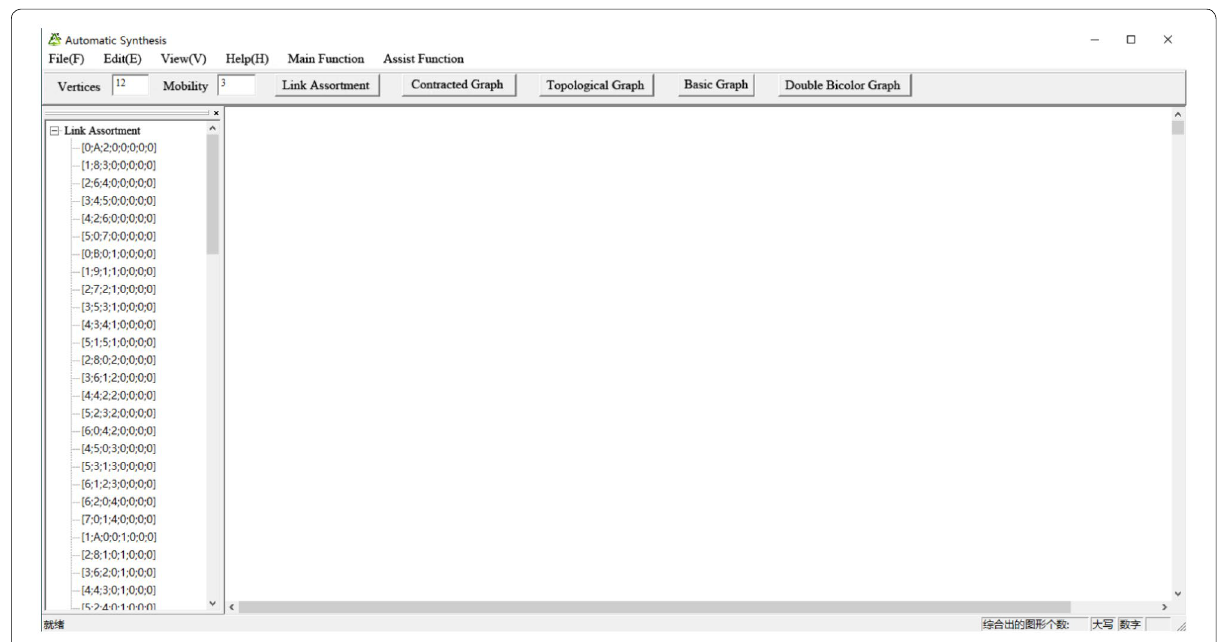
Figure 4 Link assortments of 12-vertex 3-DOF DBGs obtained from the topological graph database